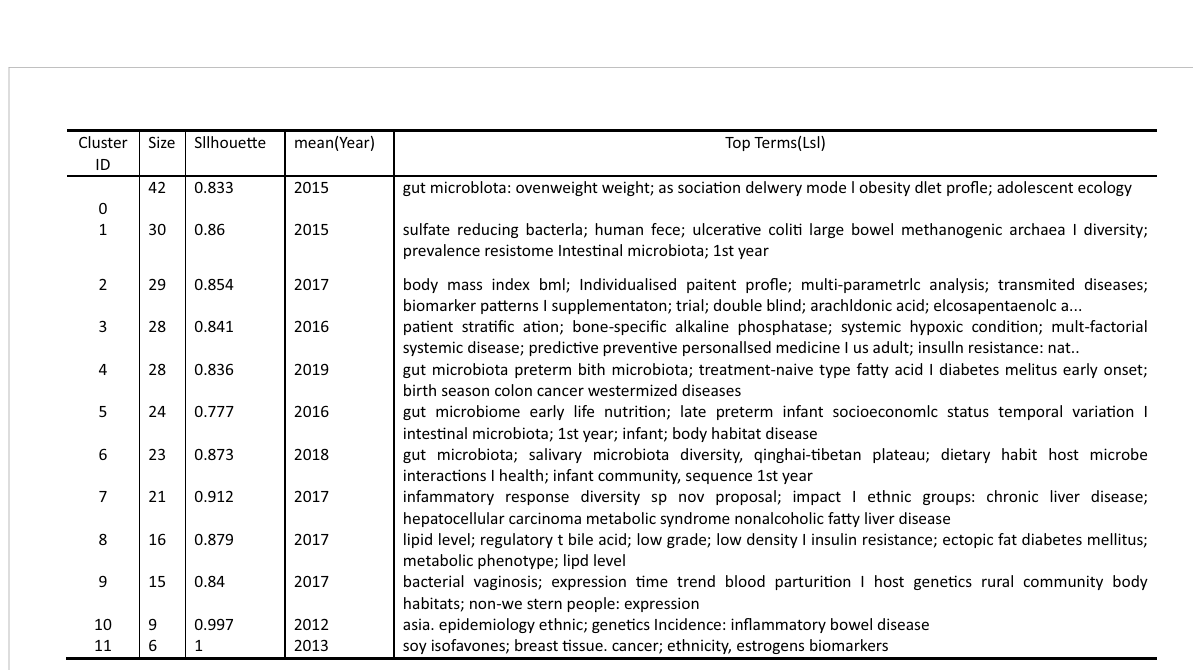
FIGURE 6 Keyword clustering. The smaller the number, the more keywords are included in the clusters, and each cluster is composed of multiple closely related